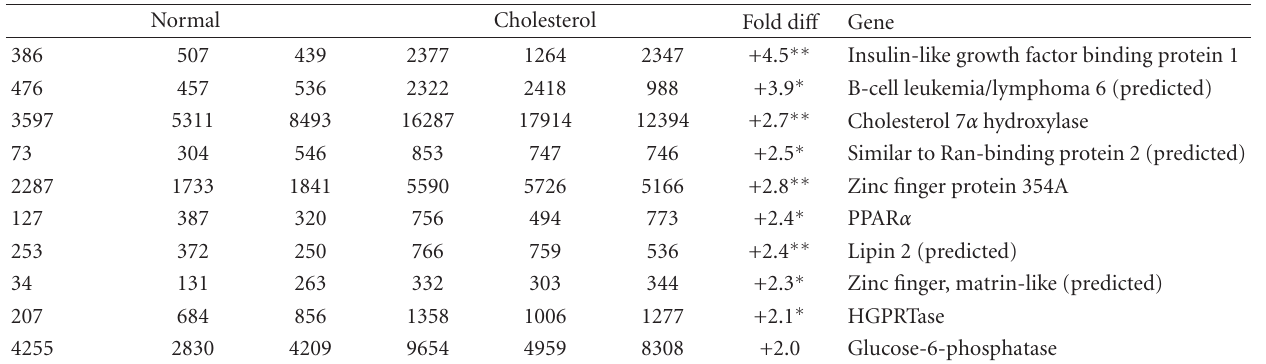
Table 3: Microarray analysis identifying genes upregulated by dietary cholesterol.